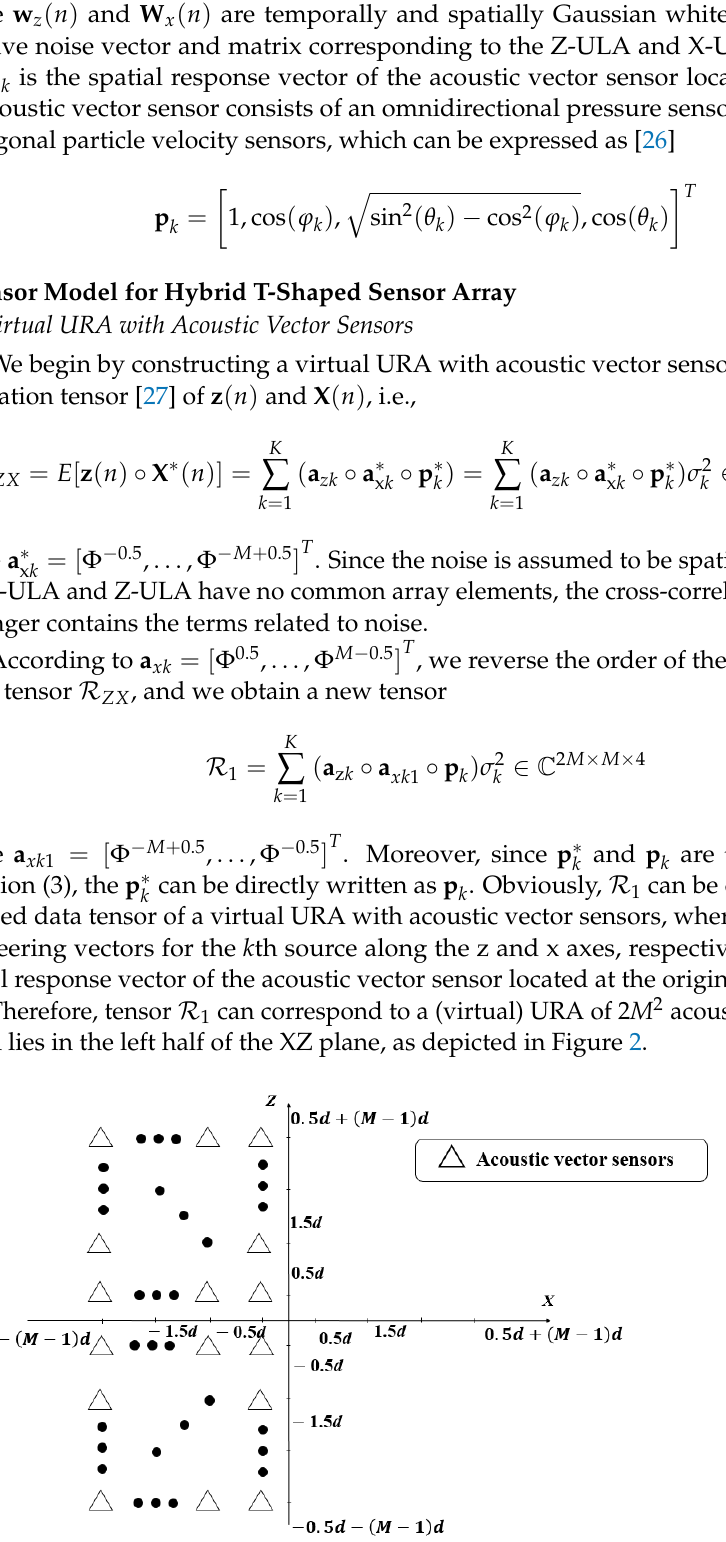
Figure 2. Virtual URA with Acoustic Vector Sensors in the left half of the XZ